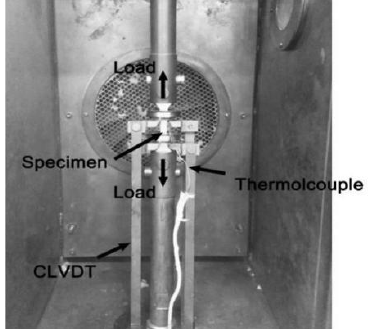
Figure 2. The tension creep testing setup.